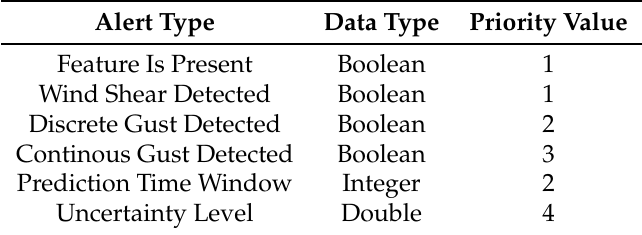
Table 3. Alerts, data types and the priority